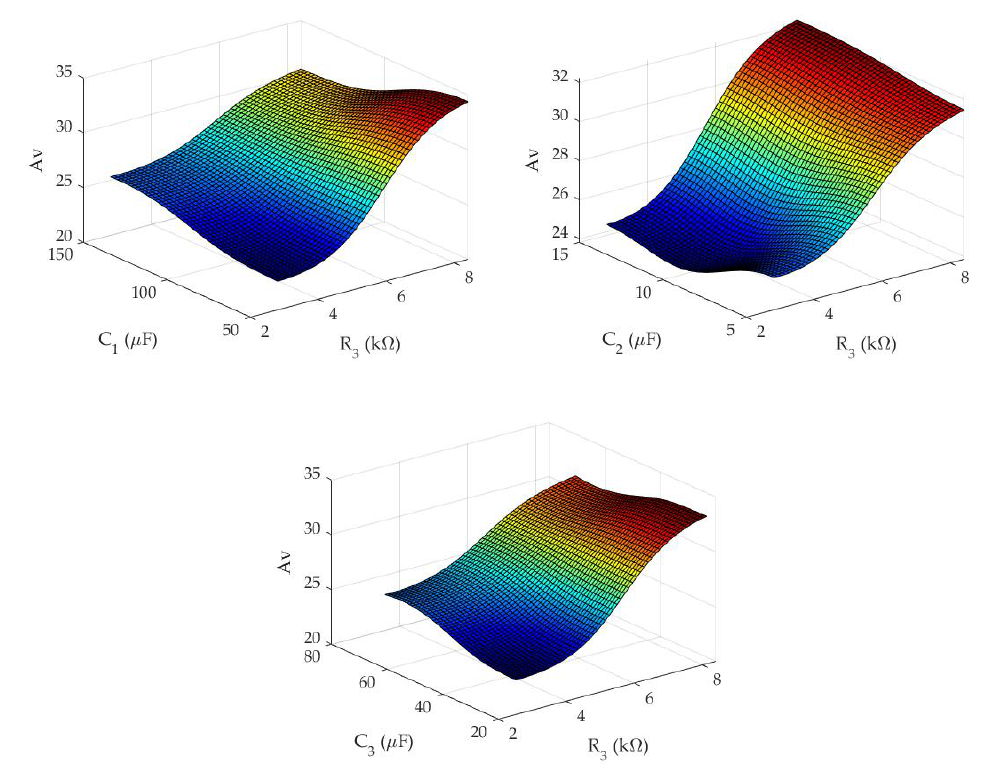
Figure 13. Response surface for Av vs. R 3 and {R 1 , R 2 , R 4 , R 5 , C 1 , C 2 , C 3 }. Figure 13. Cont